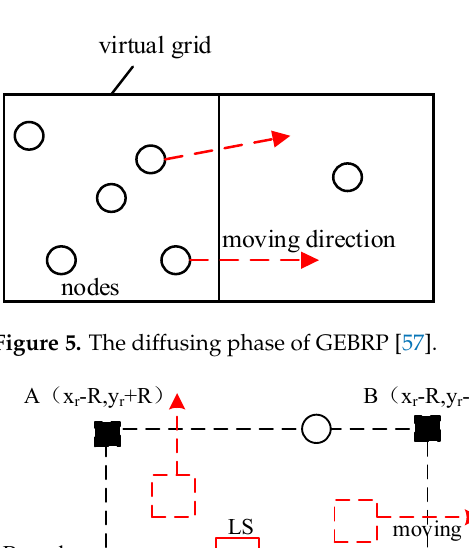
Figure 5. The diffusing phase of GEBRP [57].